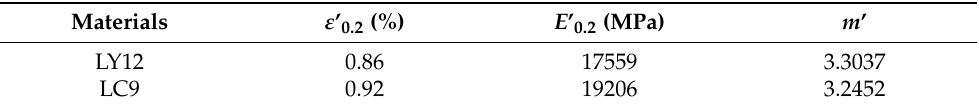
Table 4. ε ’ 0.2 (yielding strain under cyclic loading), E’ 0.2 (tangent modulus at σ ’ 0.2 ) and m’ (shape parameter under cyclic loading) of LY12 and LC9.